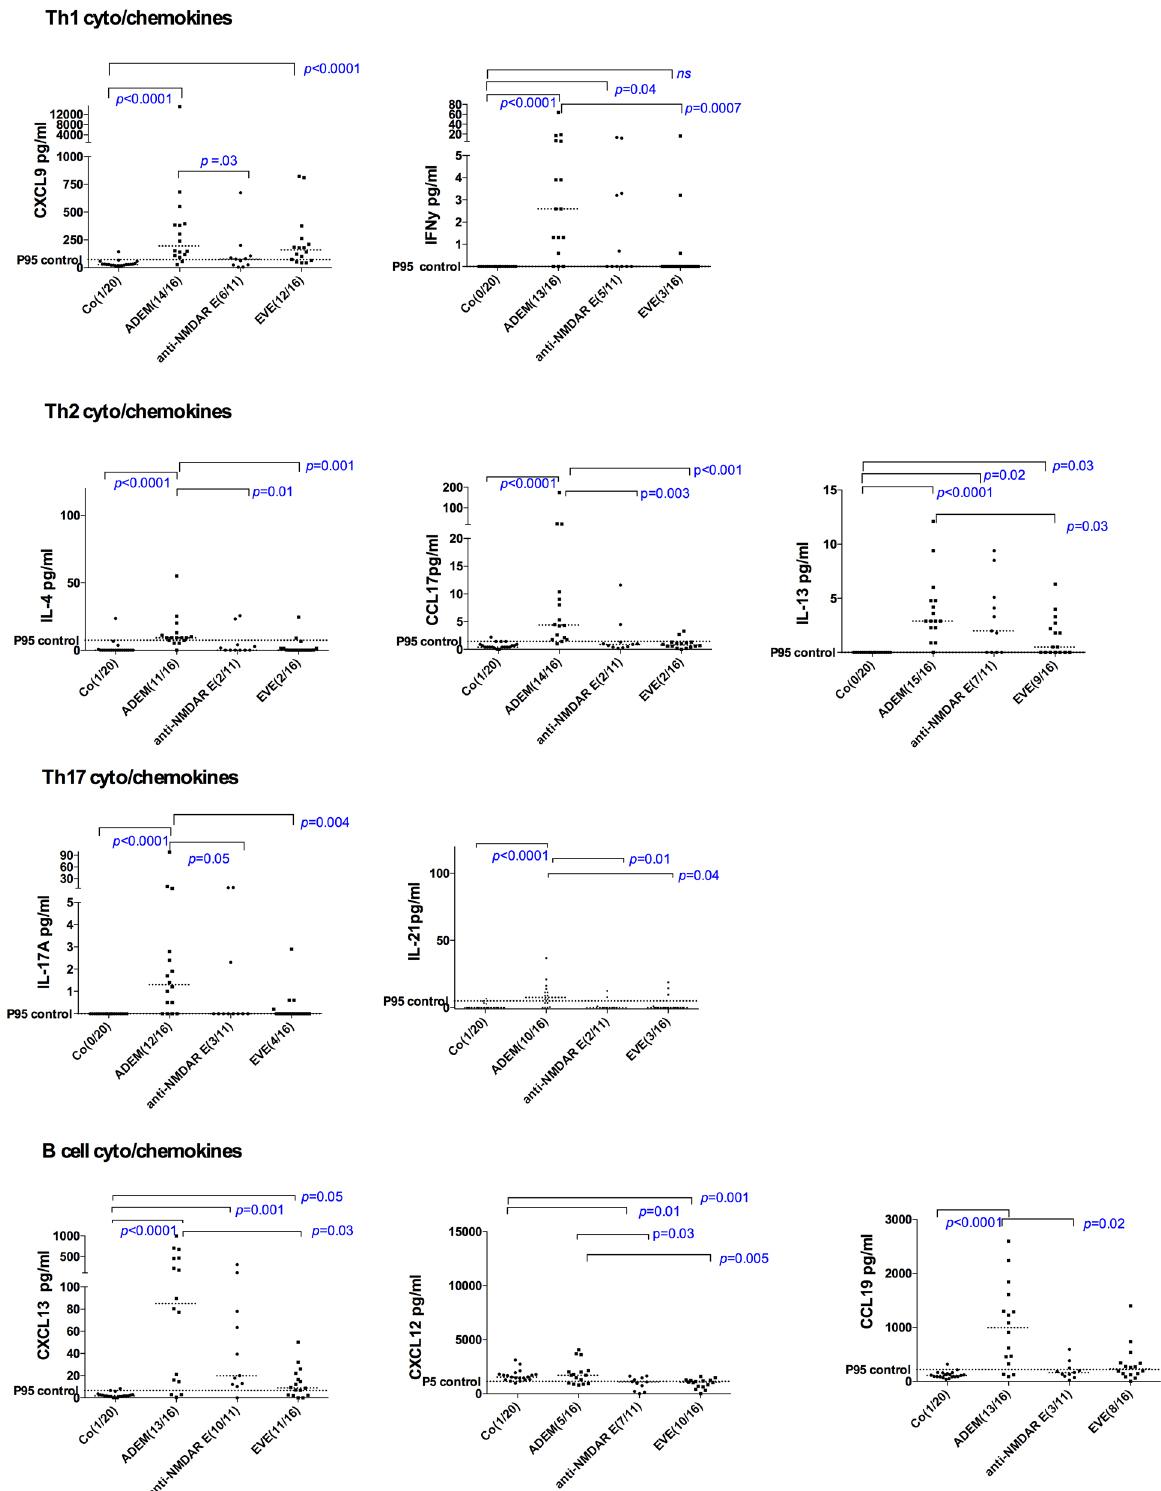
Fig 3. CSF cytokine/chemokine levels that were more elevated in ADEM compared to EVE and anti-NMDAR E. Th17 (IL-21, IL- 17A) and Th2 (CCL17, and IL-4) related cytokine/chemokines showed statistically significant elevation in ADEM compared to both EVE and anti-NMDAR E. CXCL12 showed paradoxical decrease in EVE and anti-NMDAR E, in contrast to elevation noted in ADEM.